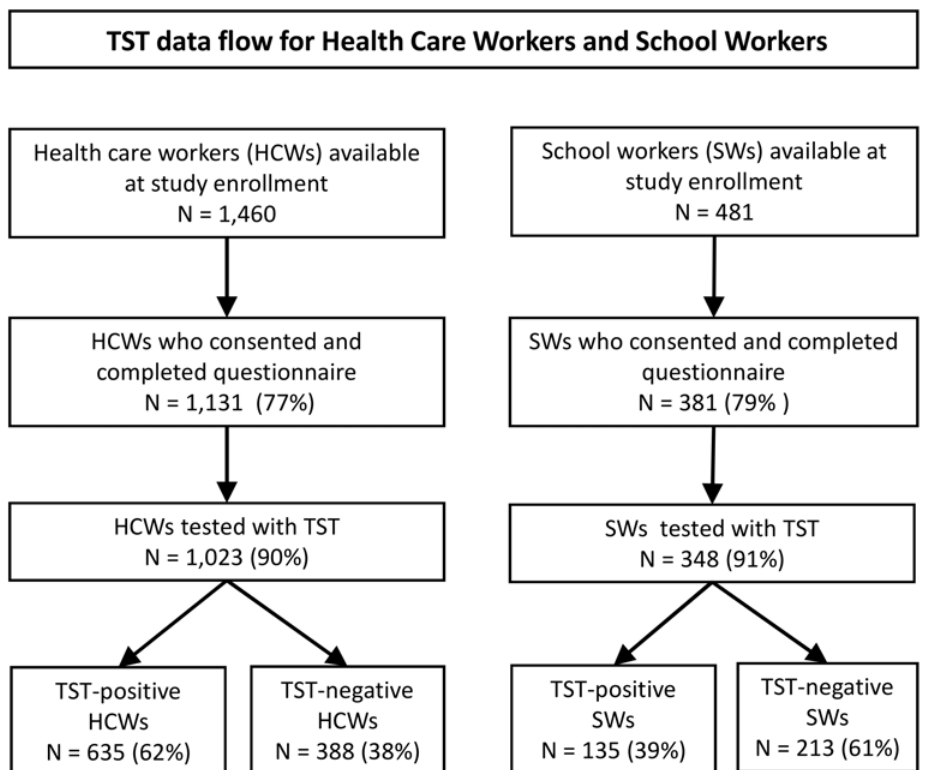
Fig 1. Data flow for health-care workers and school workers from ten health-care catchment areas in Kigali, Rwanda.